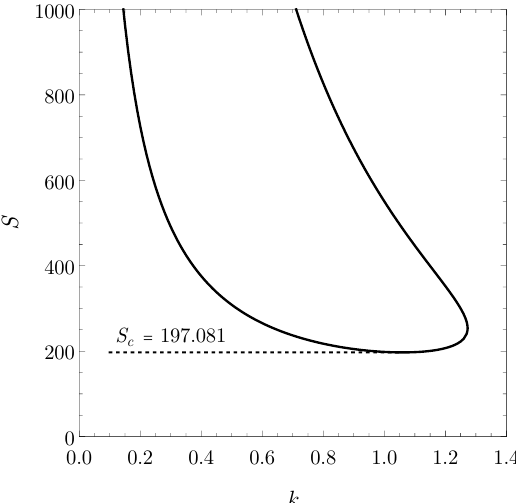
Figure 2. Neutral stability curve ( k , S ) for a Newtonian fluid.